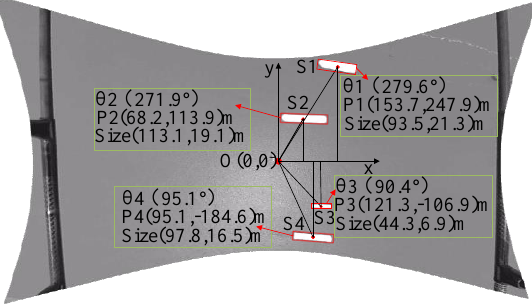
Figure 8. The vessel information extraction.